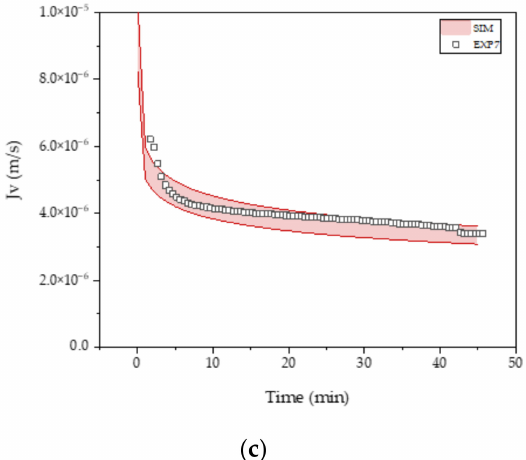
Figure 8. Flux Jv over time for experimental (squares) as well as digital twin prediction (red area) for ultrafiltration/diafiltration experiments and concentration factor 3. ( a ) Experiment 2 (EXP2): 1.5 bar transmembrane pressure (TMP), 3738 s − 1 shear rate. ( b ) Experiment 3 (EXP3): 1.5 bar TMP, 1249 s − 1 shear rate. ( c ) Experiment7 (EXP7): 0.5 bar TMP, 3738 s − 1 shear rate.